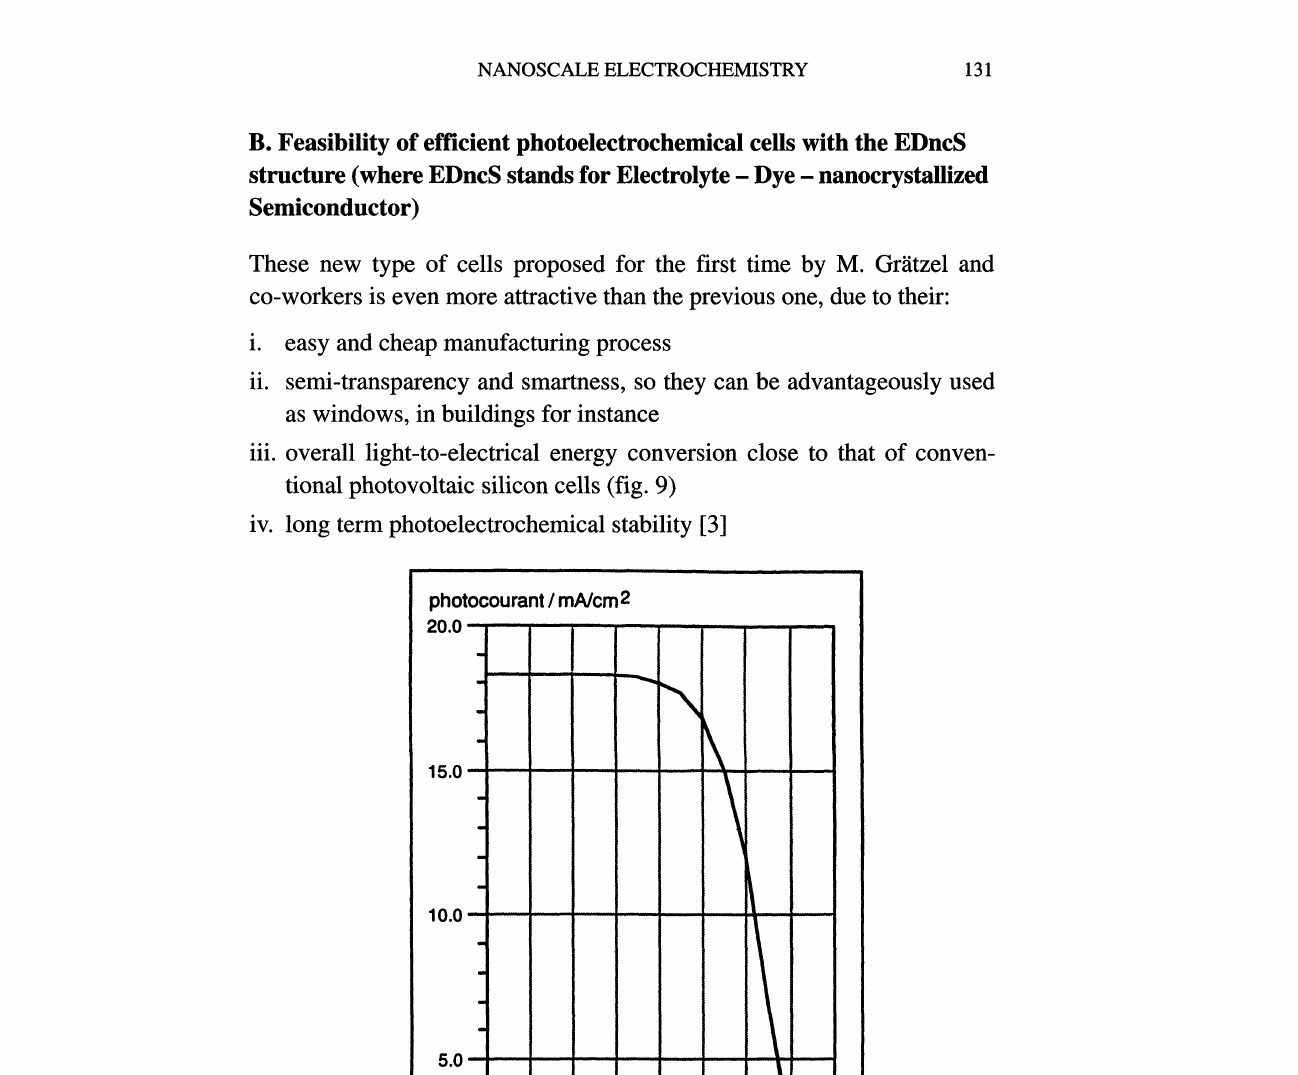
FIGURE 9 I-V Characteristic of M. Gritzel and coworkers cell. Isole light 96.4 mW/cm 2. FF 0.69" rl 8.8%,